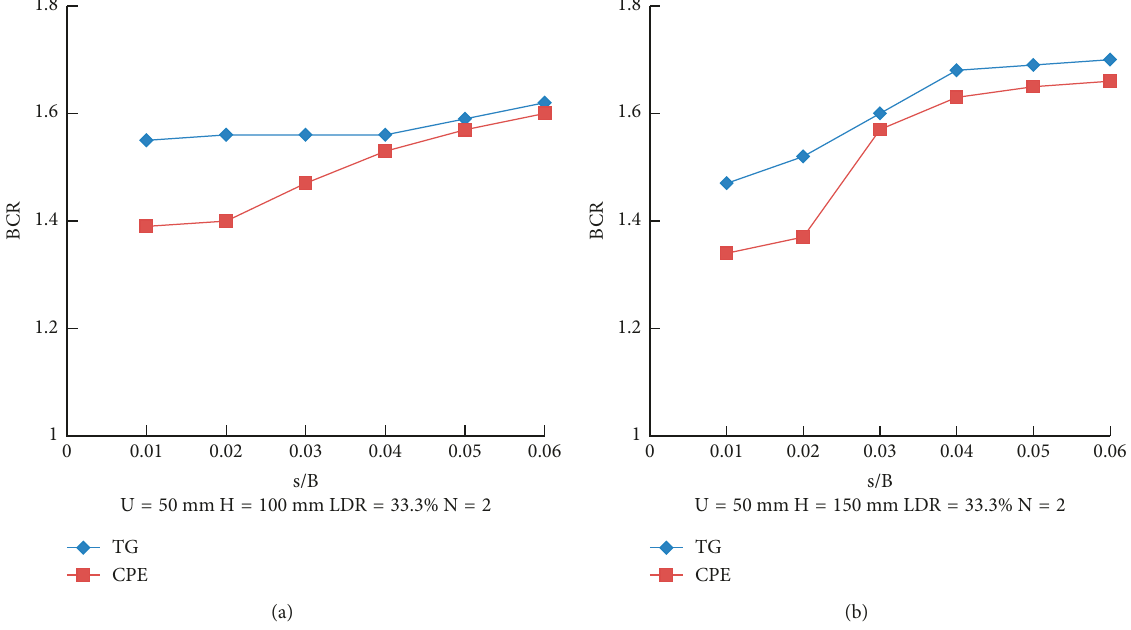
Figure 12: The relationship between BCR and geobelt type: (a) U H 150mm, LDR (cid:30)